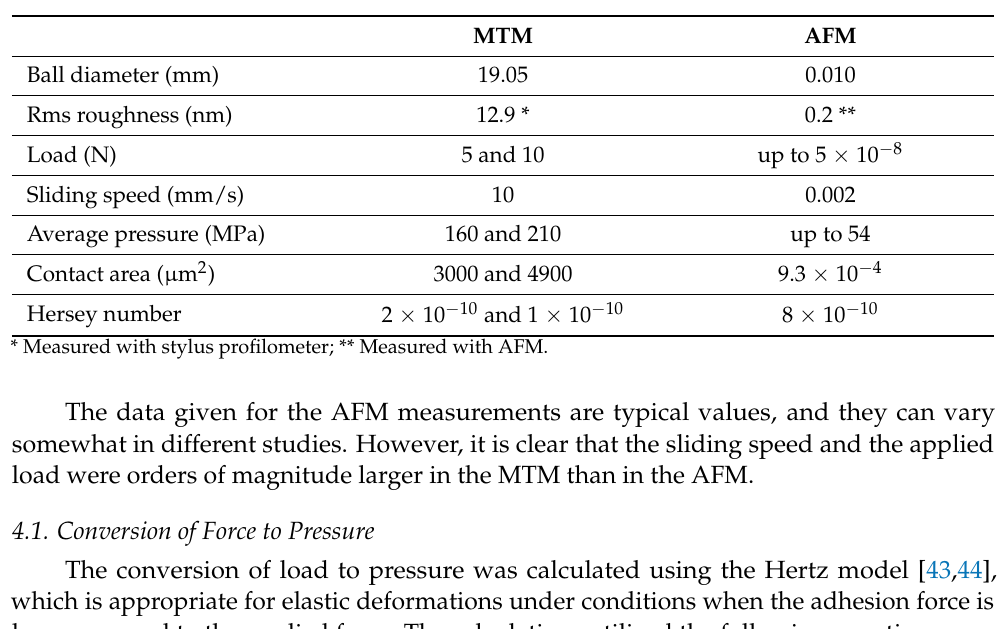
Table 1. Comparison of conditions during macroscale and nanoscale friction